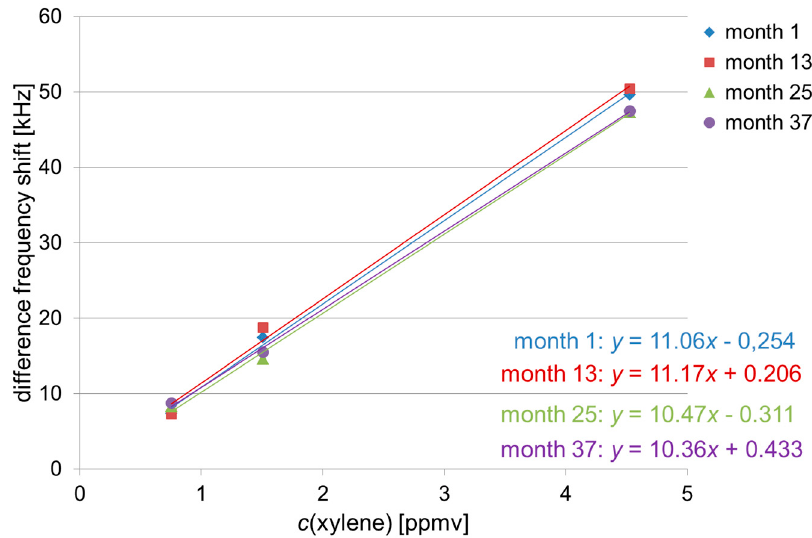
Figure 7. Mean values of sensor 1 (PBMA coating) obtained with xylene samples at the concentrations of 0.8 ppmv, 1.5 ppmv and 4.5 ppmv at annual intervals. The highest concentration was measured in triplicate, the others in duplicate. For the sake of clarity, error bars are not included. Regression lines were calculated with y = difference frequency shift [kHz] and x = c (xylene) [ppmv].